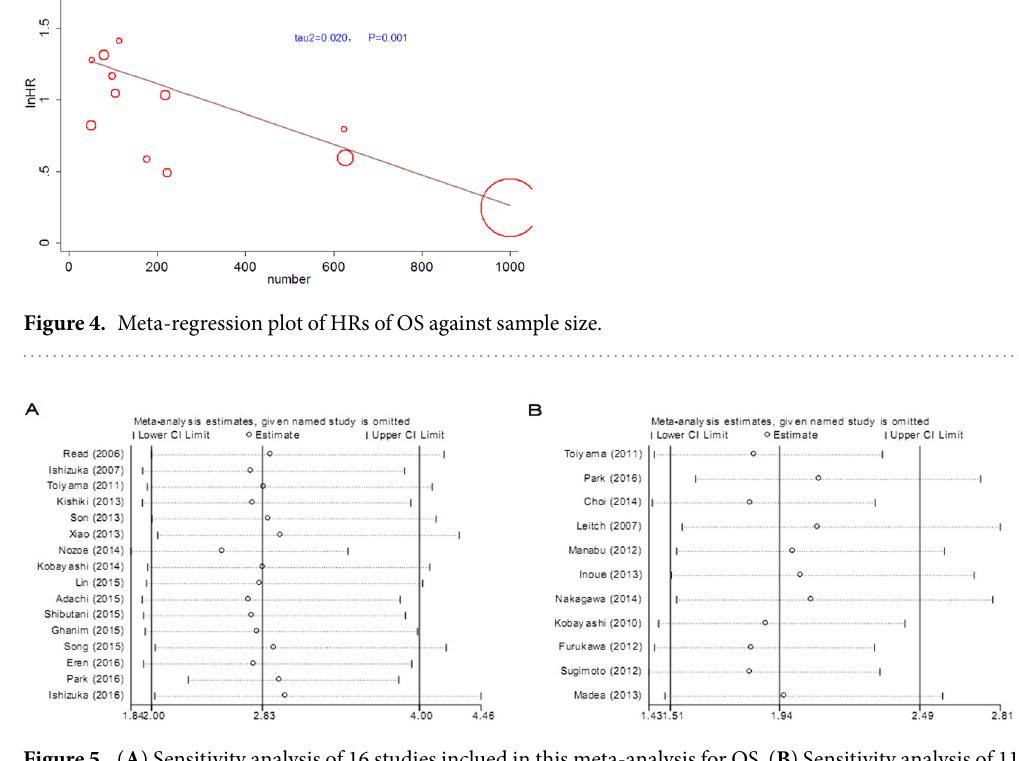
Figure 5. ( A ) Sensitivity analysis of 16 studies inclued in this meta-analysis for OS. ( B ) Sensitivity analysis of 11 studies inclued in this meta-analysis for